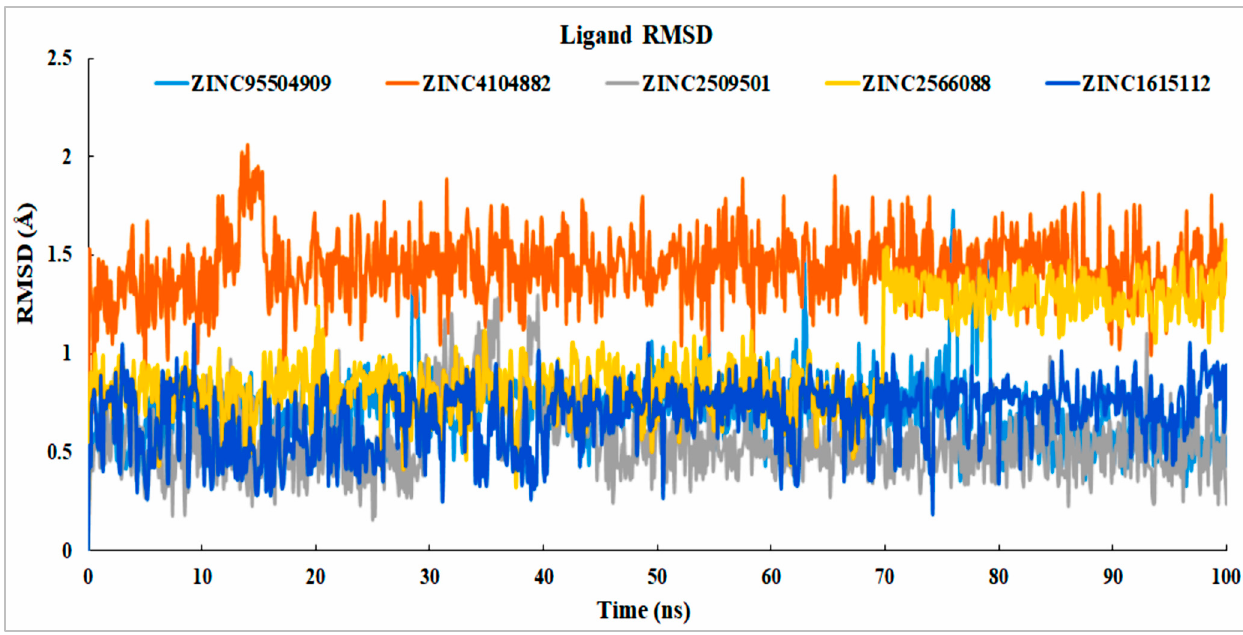
Figure 8. RMSD value determined from the protein-fitting ligand interaction. Different colors of the selected compounds, i.e., ZINC4104882 (orange), ZINC2509501 (gray), ZINC2566088 (gold), ZINC1615112 (blue), and control ligand ZINC95504909 (light blue) indicated the numbers of ligands and their expression with respect to the 100 ns simulation time.